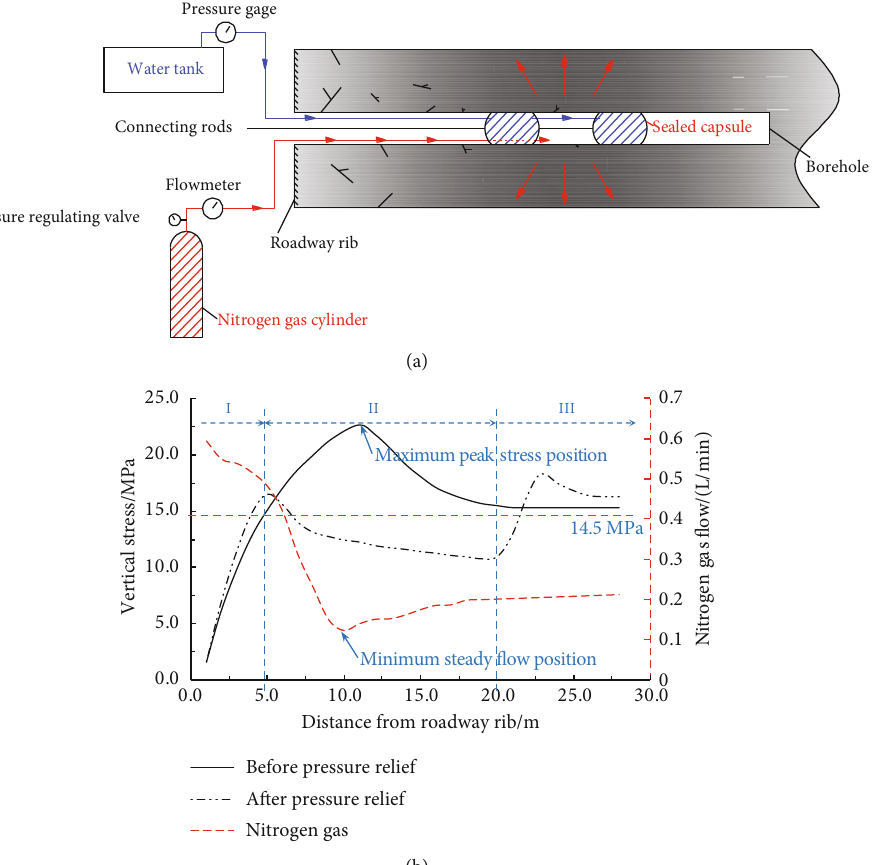
Figure 15: The numerical simulation results of water jet borehole length. (a) Schematic diagram of steady fl ow method. (b) Numerical simulation results. Note: I is the reduced pressure zone; II is the increased pressure zone; and III is the stable pressure